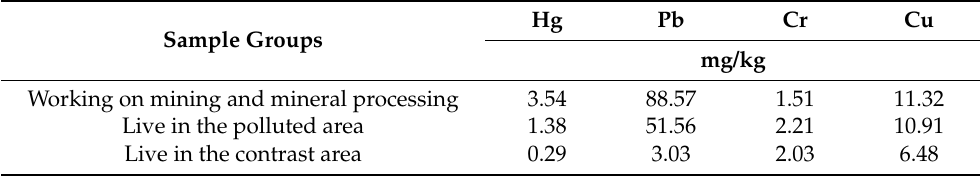
Table 8. The comparison of the toxic trace elements in human hair from the volunteers working on mining processing and the contrast